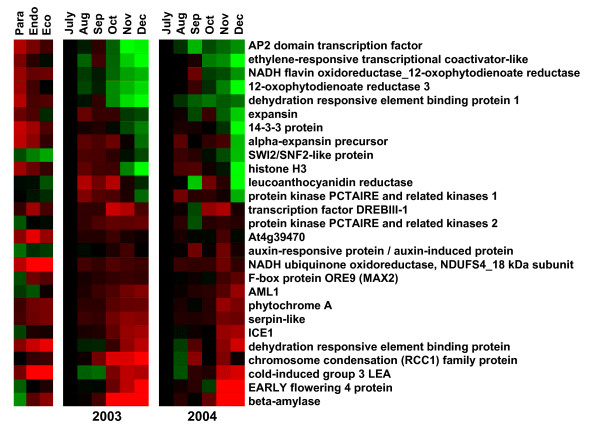
Confirmation of microarray expression profile by RT-PCR. RT-PCR analysis using crown bud RNA collected monthly during 2003 and 2004 was done on 27 selected genes. Relative gene expression levels are shown with high expression represented by red and low expression represented by green.